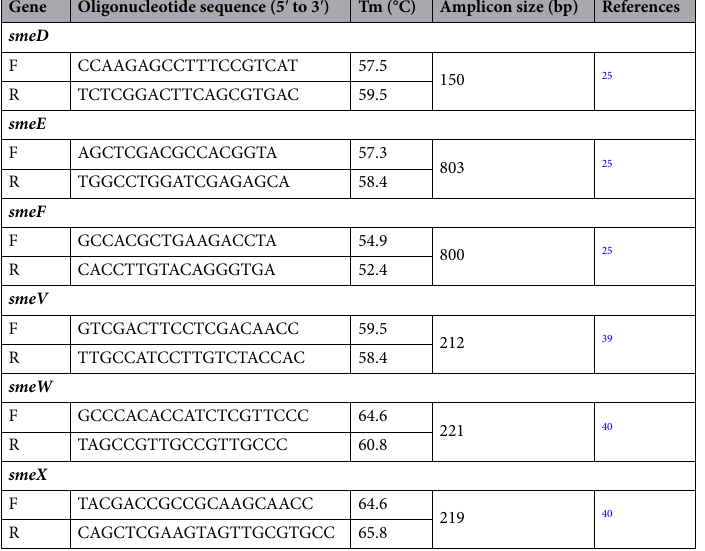
strains 34 . A representative amplicon of 23S rRNA gene was subjected to sequencing and the sequence was depos- ited in GenBank under the accession no. JQ889327 (https:// www. ncbi. nlm. nih. gov/ nucco re/ JQ889 327). Antimicrobial susceptibility testing. Antibiotic susceptibility testing of the isolates against ciprofloxa- cin (5 µg), levofloxacin (5 µg) and moxifloxacin (5 µg) (Mast Group Ltd, UK) was determined using the disk diffusion method on the Mueller–Hinton agar (Merck, Germany) plates according to Clinical and Laboratory cin and levofloxacin were determined by broth microdilution method for the isolates which were considered as ciprofloxacin-intermediate/-resistant according to the disk diffusion method. In other words, 50 isolates were selected for this experiment, in which 41 isolates were ciprofloxacin resistant and the remaining nine isolates were among the ciprofloxacin-intermediate-susceptible isolates which were selected based on isolation date, sources, the presence of resistance genes and MICs). In brief, twofold serial dilutions of ciprofloxacin and levo- floxacin were prepared in 96-well microplates containing Mueller–Hinton broth (Merck, Germany) to obtain the concentration ranging from 0.25 to 128 μg/mL. The 0.5 MacFarland bacterial suspensions were used and the final concentration was equal to 5 × 10 5 CFU/mL. The plates were sealed and incubated for 20–24 h at 35 °C. The critical breakpoints of ciprofloxacin for Pseudomonas aeruginosa were used for interpretation of the results because of no breakpoints for S. maltophilia were recommended by the CLSI 35 and the results of moxifloxacin were interpreted according to the British Society for Antimicrobial Chemotherapy (BSAC) guidelines 36 . The S.